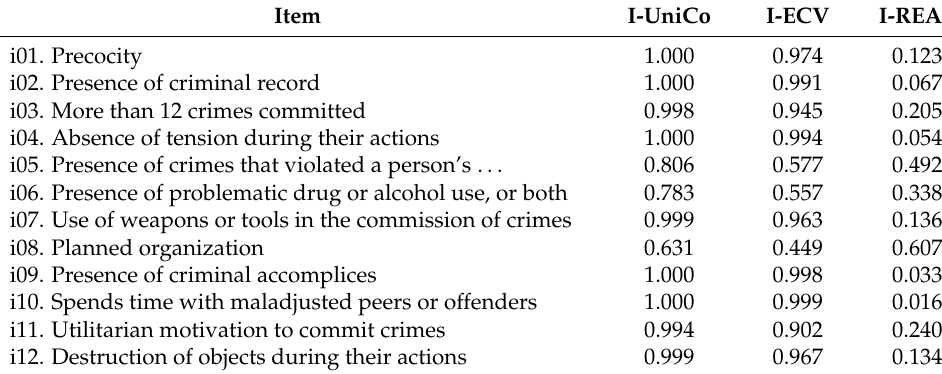
Table 6. Evidence of Unidimensionality on the EGED. Item I-UniCo I-ECV I-REAL